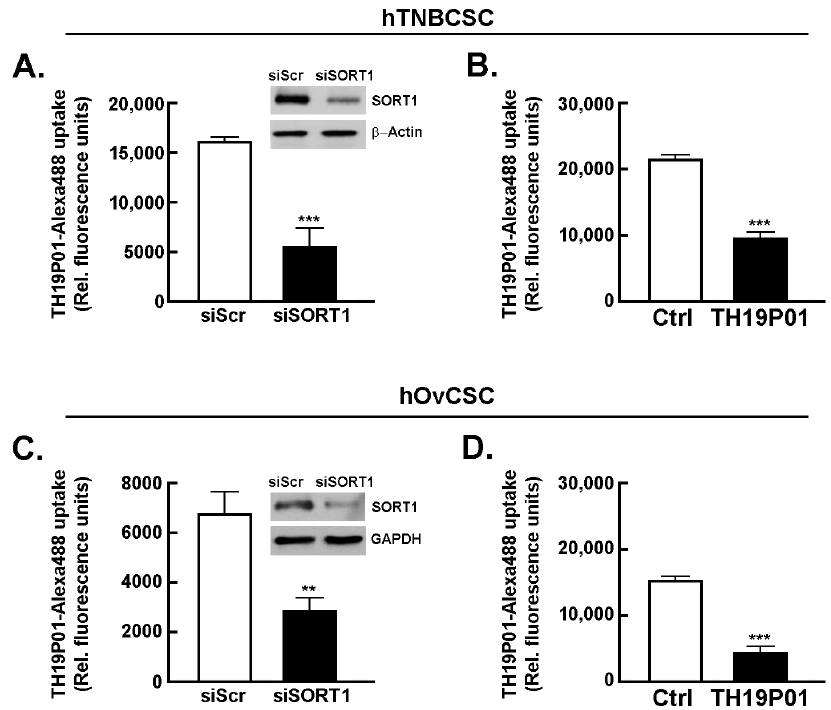
Figure 2. SORT1 is required for the internalization of TH19P01 in hTNBCSC and hOvCSC. SORT1 siRNA-mediated transient gene silencing was performed as described in the Methods sec- tion, and a Western blot performed to evaluate the extent of SORT1 protein expression decrease in ( A ) hTNBCSC (insert) and ( C ) hOvCSC (insert). siScr is a scrambled random sequence of siRNA and serves as a control. β -Actin or GAPDH were used as a loading controls. Transfected cells were then incubated with fluorescent Alexa 488 -TH19P01 peptide as described in the Methods section. Untransfected cells were also exposed to media supplemented with DMSO alone (Vehicle), or 50 µ M TH19P01 to monitor Alexa 488 -TH19P01 peptide uptake for ( B ) hTNBCSC or ( D ) hOvCSC. The flu- orescence contained within the cells was measured by flow cytometry after cells were incubated for 2 h, washed and trypsinized. Fluorescence associated with Vehicle alone reflects background fluo- rescence of the system. The data shown represent means ± SEM, n = 3, each performed in duplicate. Statistical comparison was performed using t -test, comparing all other samples to the cells incu- bated with Alexa 488 -TH19P01 alone. Significance was assumed for ** p < 0.01. *** denotes p < 0.001.